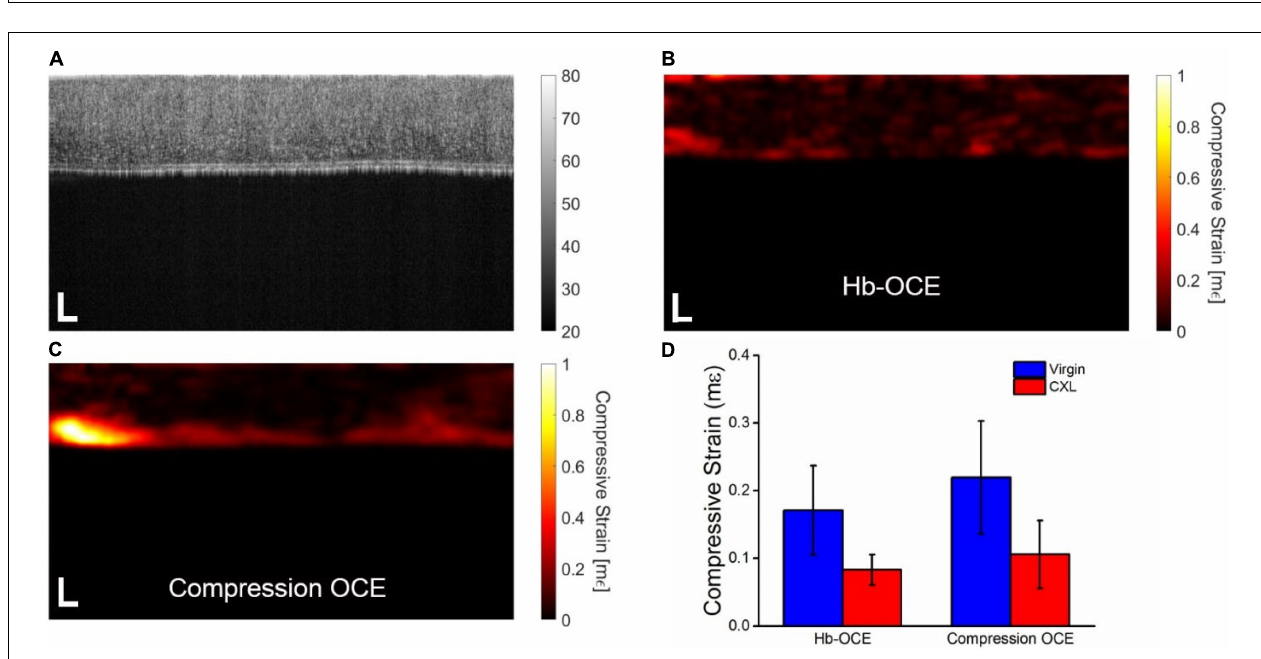
FIGURE 2 | (A) OCT intensity B-scan of a representative virgin cornea. Corneal stiffness mapped by (B) Hb-OCE and (C) compression OCE. (D) Box and whisker plot comparing measurements performed by Hb-OCE and compression OCE ( n = 7). The box shows median and upper and lower quartiles, and the whiskers represent the minimum and maximum data points. Scale bars indicate 100 µ